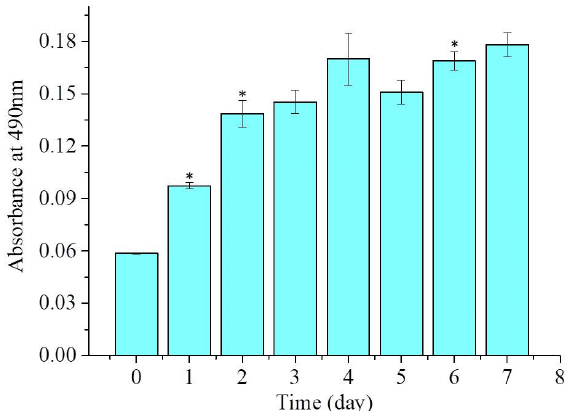
Figure 6. Viability of MCF-7 cells in formed thermosensitive P(OEGMA-co-MEO 2 MA) hydrogel as assessed by MTT assay. The data shown are the mean of three independent experiments. Error bars indicate the standard deviations. An asterisk (*) indicates a significant difference between this group of data and the previous group ( p < 0.05).